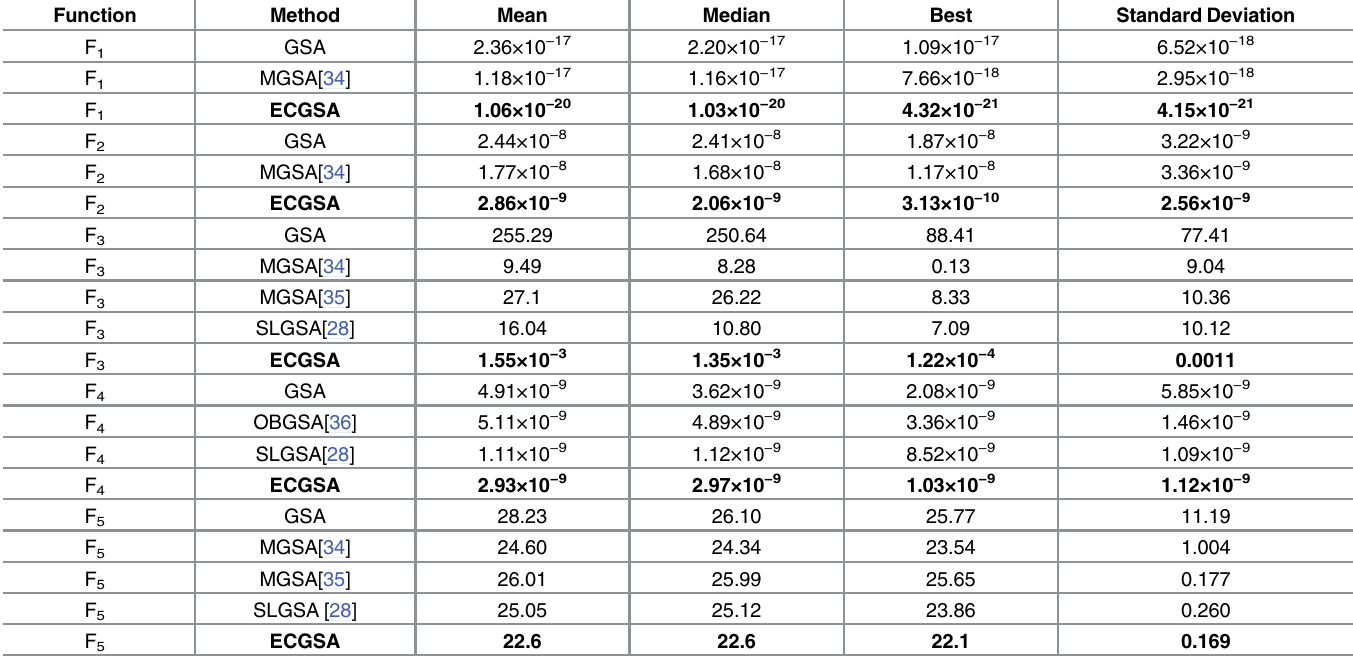
Table 3. Minimization result of the unimodal benchmark functions in Table 1.